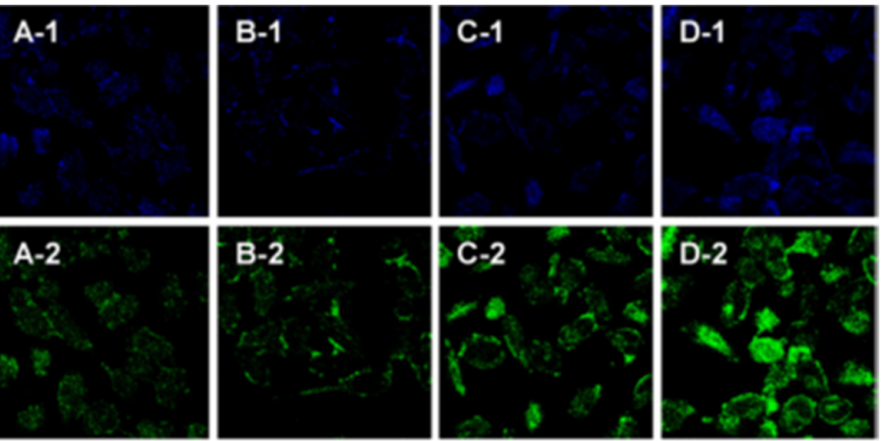
Figure 4. Confocal micrographs of HeLa cells incubated with 1 mg mL − 1 folic acid-encapsulated GQDs for 6 h at various pH (5, 6, 7, and 8; A , B , C , and D respectively). 1 (425–490 nm, λ ex 405 nm) and 2 (500–570 nm, λ ex 488 nm) refer to the different spectral windows. Reproduced with permission [220]. Copyright 2018